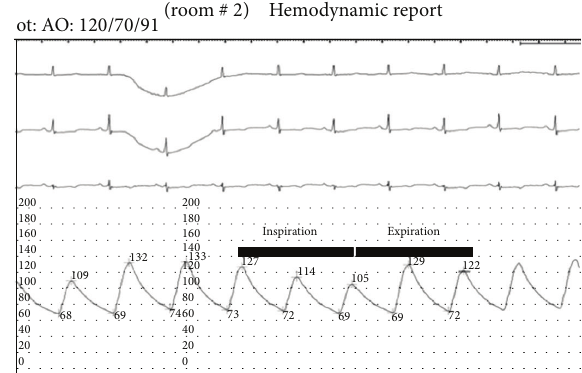
Figure 5: Blood pressure variation following aortic dissection with the inspiratory and expiratory phases denoted by the solid line. The inspiratory phase corresponds to a systolic blood pressure drop of about 22